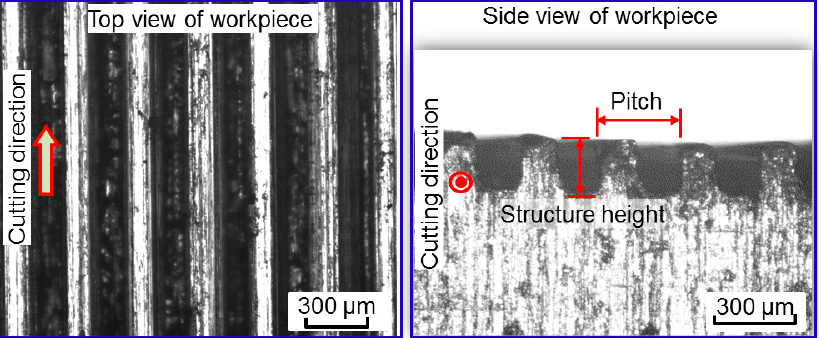
Figure 6. Machined micro structures on aluminum alloy by applying textured cutting tool.